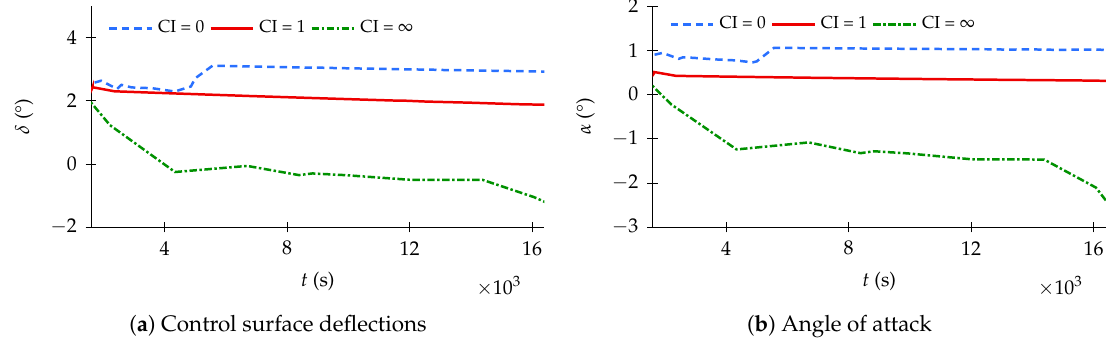
Figure 12. ( a ) control surface deflections and ( b ) angle of attack of the PrP using DLC—details of the cruise phase for different CIs.